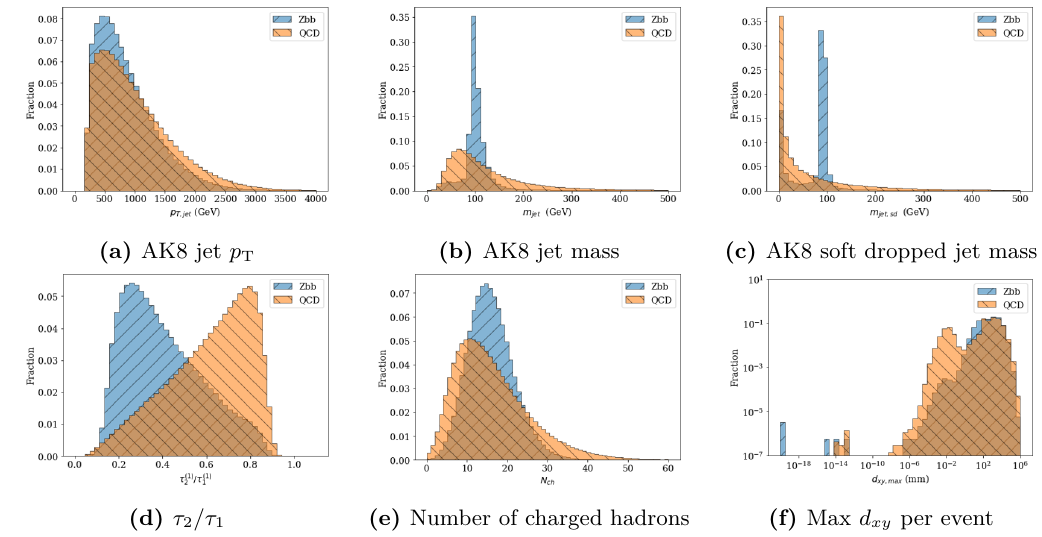
Figure 8. Input distributions to training for Zbb and QCD events. Shown are the jet p T (upper left), ungroomed jet mass (upper middle), groomed jet mass with the soft drop algorithm (up- per right), n-subjettiness ratio τ 2 /τ 1 (lower left), charged hadron multiplicity (lower middle), and d xy, max (lower